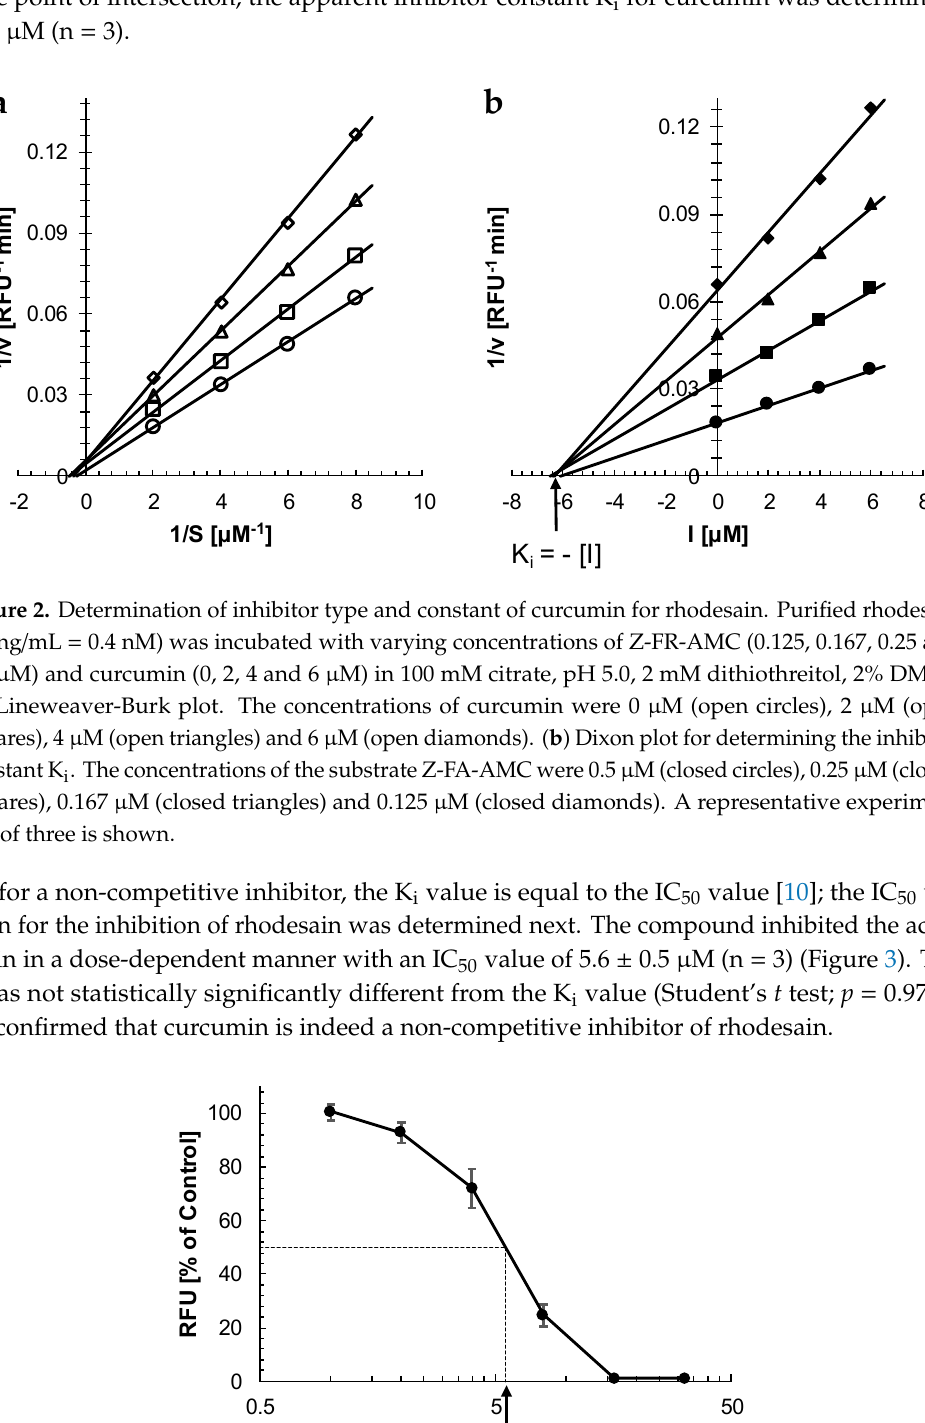
Figure 3. Dose-response curve of the inhibition of rhodesain by curcumin. Purified rhodesain (7 ng / mL; 0.2 nM) was incubated with varying concentrations of curcumin (32, 16, 8, 4, 2 and 1 µ M) in 100 mM citrate, pH 5.0, 2 mM dithiothreitol, 2% DMSO, 5 µ M Z-FR-AMC. After 10 min, the fluorescence of liberated AMC was measured. The experiment was repeated three times and mean values ± SD are shown.